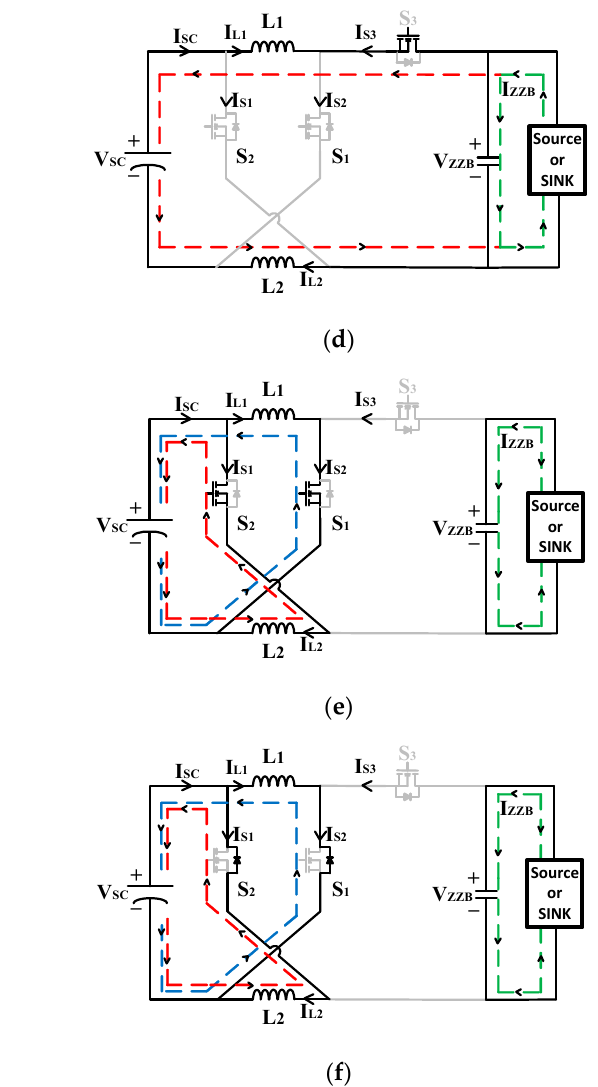
Figure 5. The current flow path for the ZZB during charging and discharging of SC. During discharging of the SC: ( a ) 0 < t ≤ t 0 ; ( b ) t 0 < t ≤ t 1 ; ( c ) t 1 < t ≤ t 2 . During charging of the SC: ( d ) 0 < t ≤ t 0 ; ( e ) t 0 < t ≤ t 1 ; ( f ) t 1 < t ≤ t 2 [49].